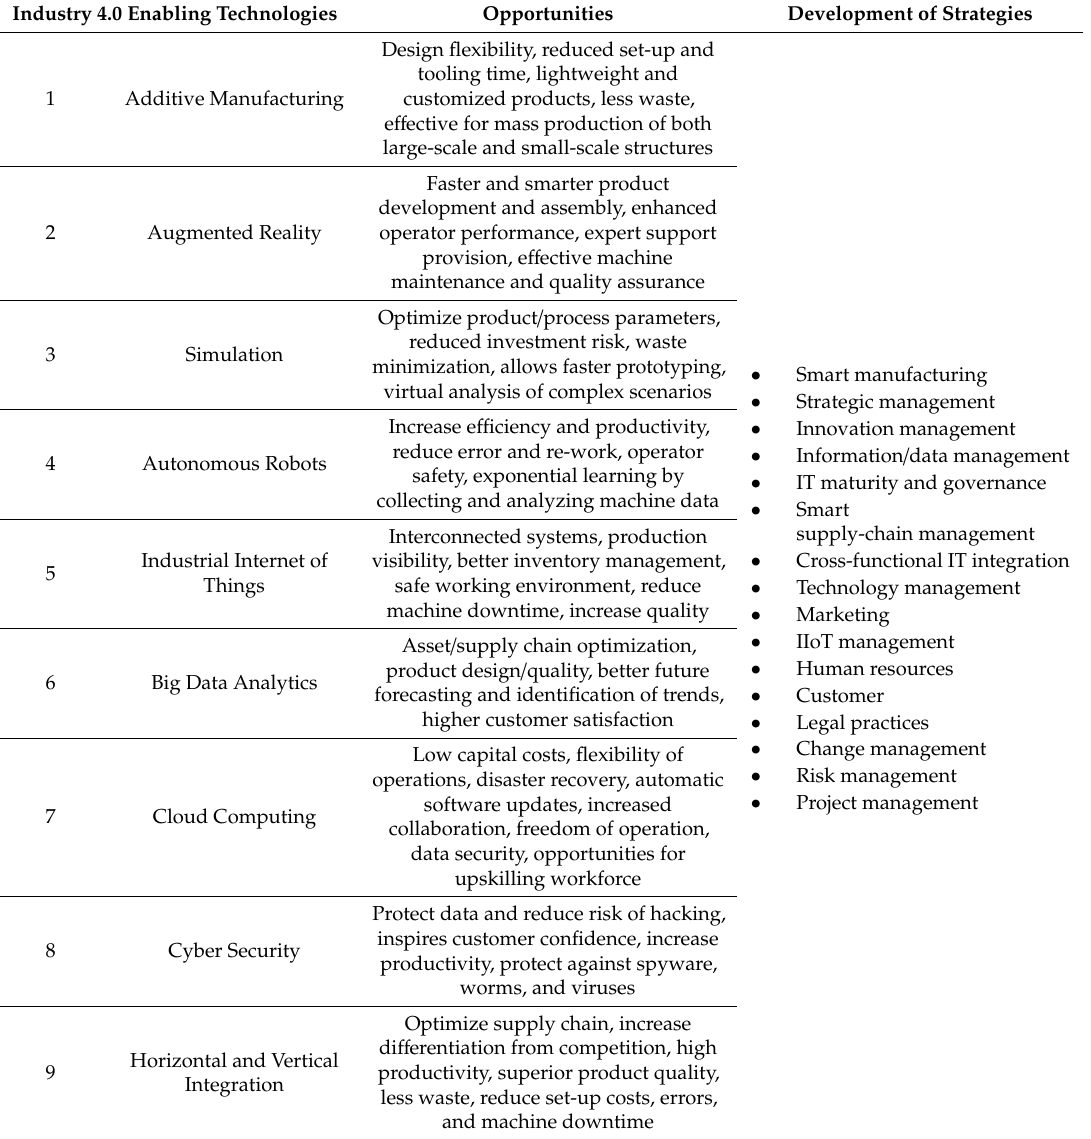
Table 1. Opportunities o ff ered by Industry 4.0 enabling